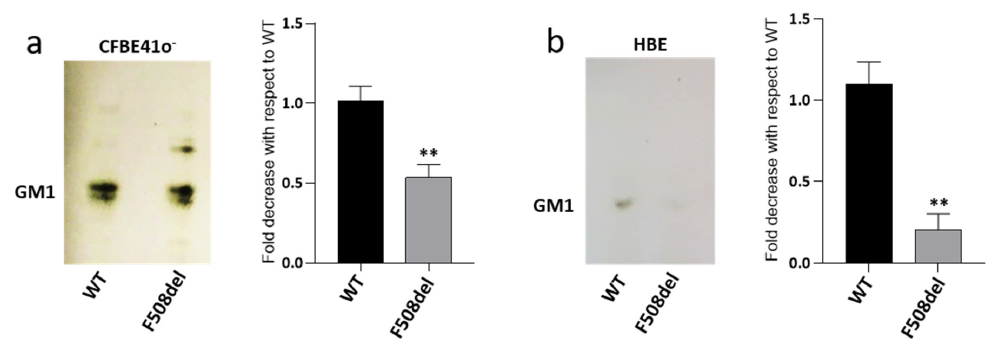
Figure 1. GM1 levels are decreased in both CFBE41o − and human primary bronchial epithelial cells expressing F508del CFTR. GM1 of CFBE41o − overexpressing the WT or F508del form of CFTR, ( a ) and of human primary bronchial epithelial cells (HBE) derived from CF (F508del) and non-CF (WT) subjects; ( b ) Gangliosides were extracted from cells, separated by thin layer chromatography (TLC) and visualized by TLC immunostaining using cholera toxin. GM1 levels were quantified using ImageJ software and represented in the graphs as fold decrease with respect to WT. ** p < 0.003 vs.